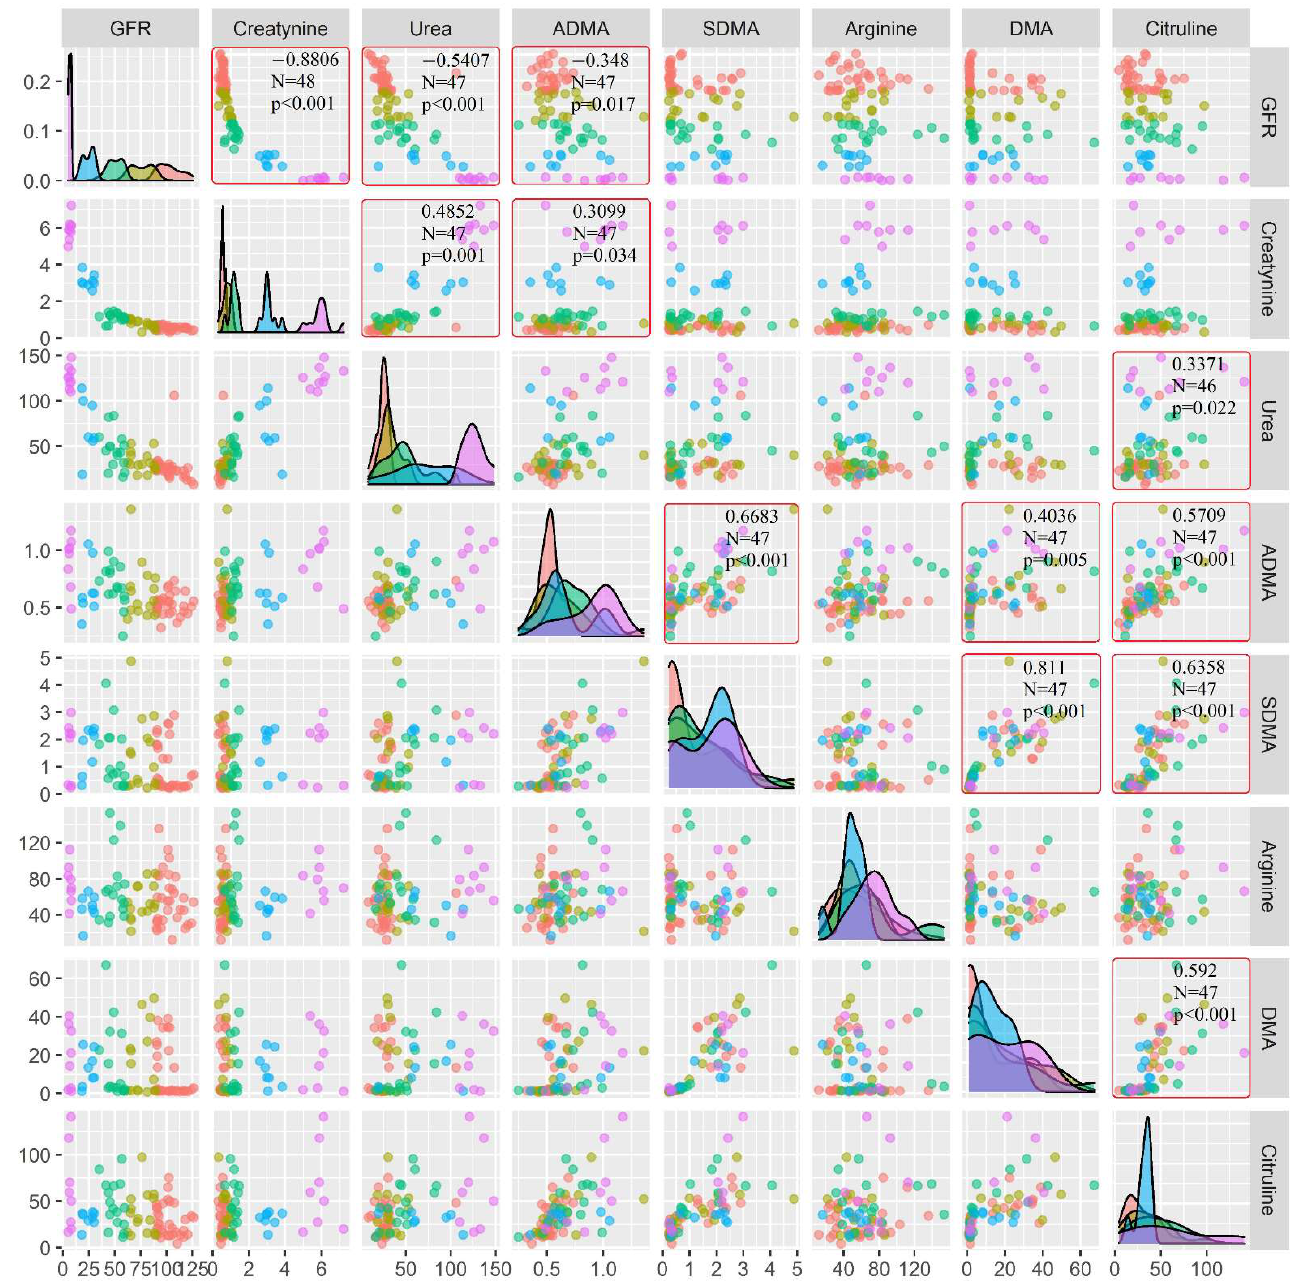
Figure 4. Correlations between studied NO synthesis metabolites. Legend: purple—healthy group, blue—Stage II CKD, green—stage III CKD, yellow—stage IV CKD, red—RRT. Density plots are